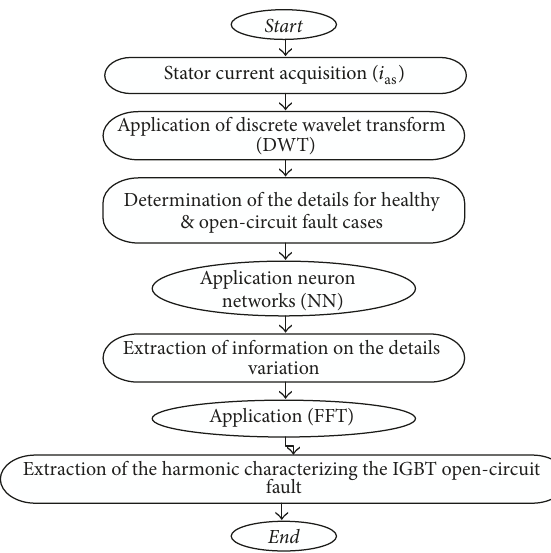
Figure 2: Flowchart of the proposed DWT-NN